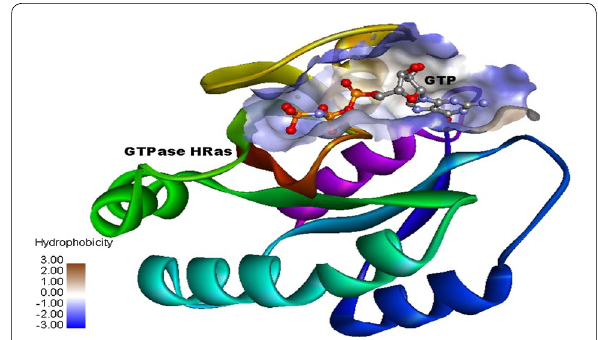
Fig. 1 Binding site of GTP used for docking of compounds